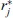
Distinct local dynamics of hub and peripheral nodes.A coupled Stuart-Landau model oscillator was simulated on a scale-free network with 78 nodes; distinct local dynamics at hub nodes (green triangle: defined as nodes with degree above the group standard deviation), and peripheral nodes (yellow circle: defined as nodes with degree 1) are found as coupling strength S is varied. (A) Mean phase coherence (PC), (B) amplitude, and (C) averaged dPLI for the two groups of nodes are presented. (D) The average coupling strength of j, K
j, is shown as function of amplitude  rj*. Here, R˜ is the order parameter. We analytically identified that (KjR˜)2 is a monotonic increasing function of (rj*)2, such that if Ka>Kb, then  ra*>rb*. For the simulation, the time delay between each node was given as 10ms.